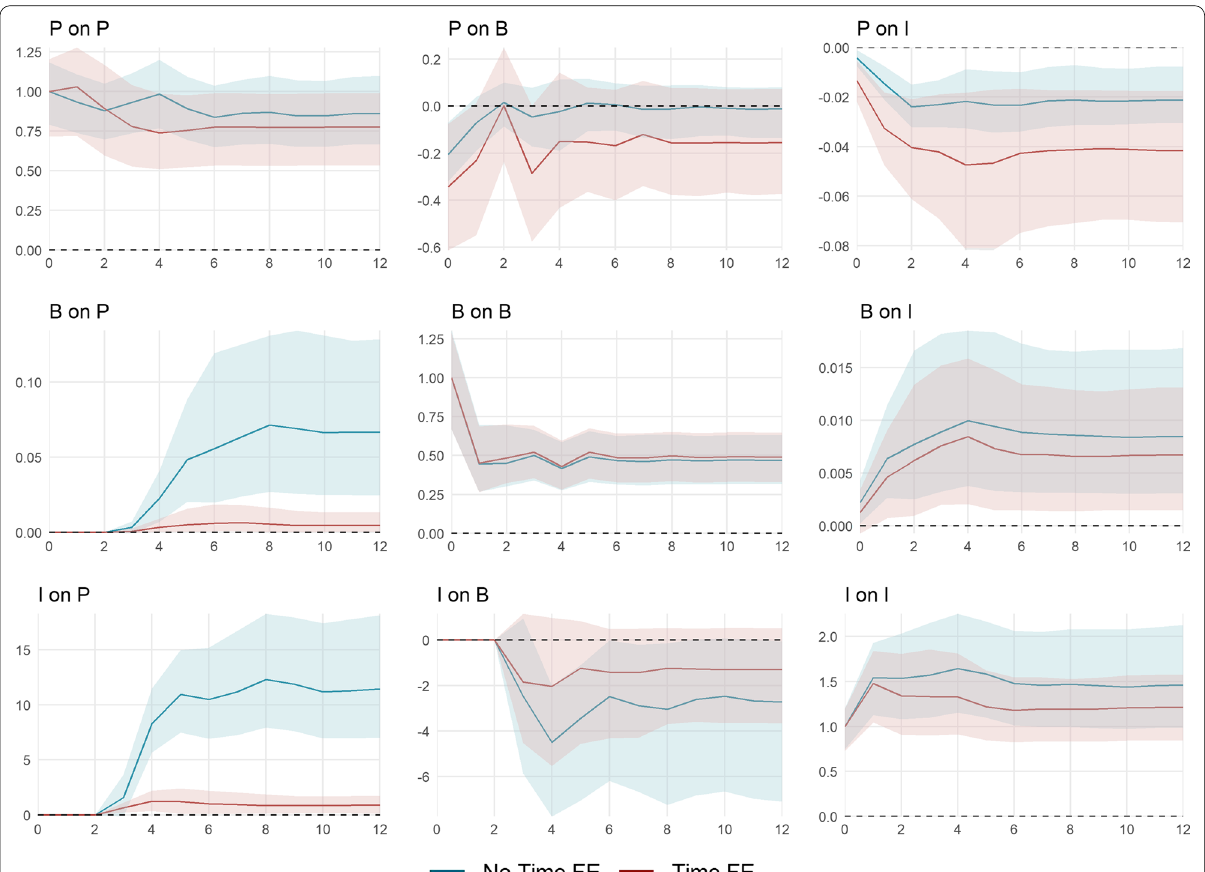
Fig. 11 Cumulative impulse responses of policy P , behavior (mobility) B , and infection growth I . The impulse responses are estimated using the recursively ordered VAR(4) in (4) with k September 28, 2020, until April 18, 2021. The shaded areas represent the 95% confidence intervals based on a wild bootstrap procedure with 5000 repetitions. The horizontal axes depict the time horizon in weeks. The vertical axes show the level response of the KSI + (left), dist (middle) and lnNINF